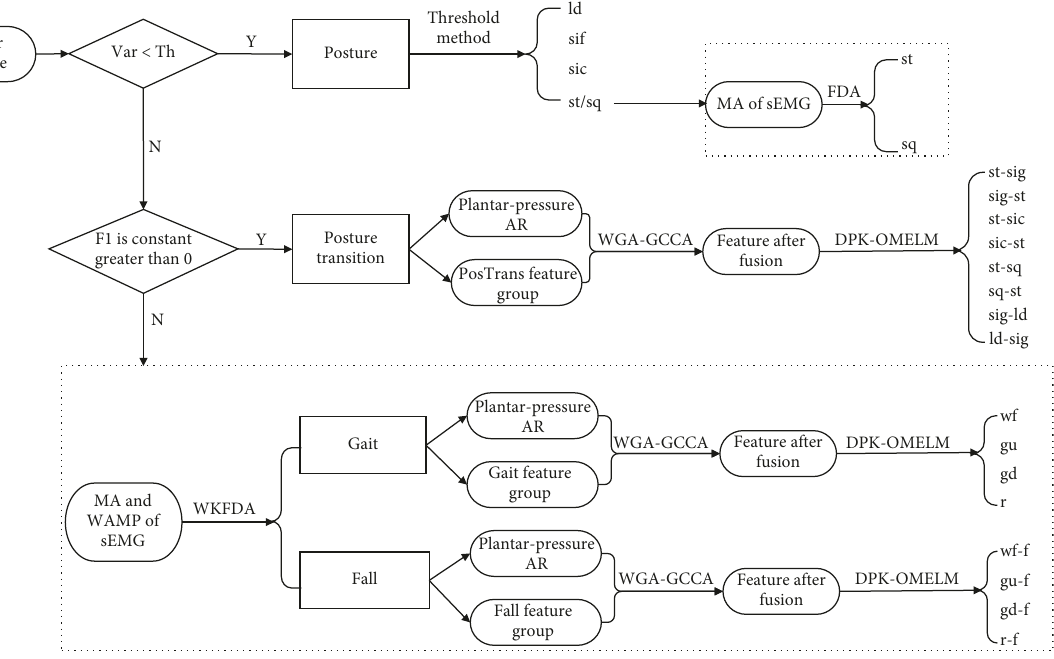
Figure 8: Flowchart of the daily activity monitoring and fall detection